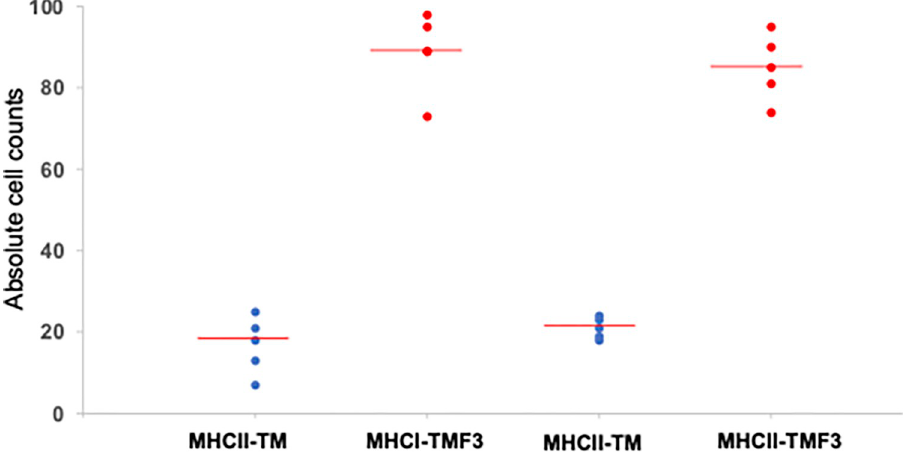
Fig 3. Absolute counts for expression of MHC class I and class II molecules in treated and untreated tumors. P values were calculated using Mann-Whitney test for comparison of absolute cell counts between untreated (TM) and treated (TM-F3) tumor-bearing